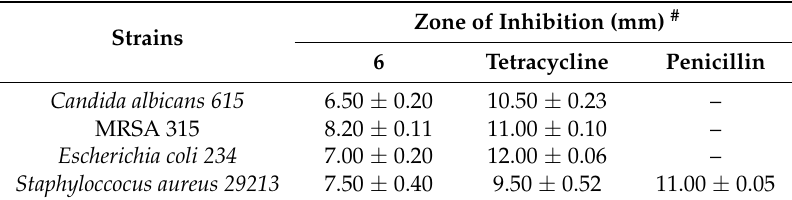
Table 4. Antimicrobial activity of compound 6